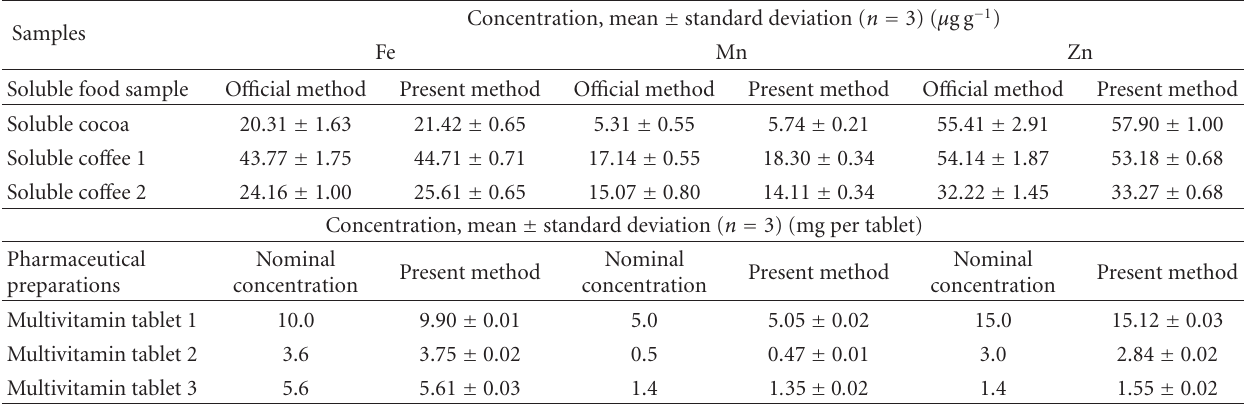
Table 2: Determination of Fe, Mn, and Zn in soluble foods and pharmaceutical samples and paired t -test.